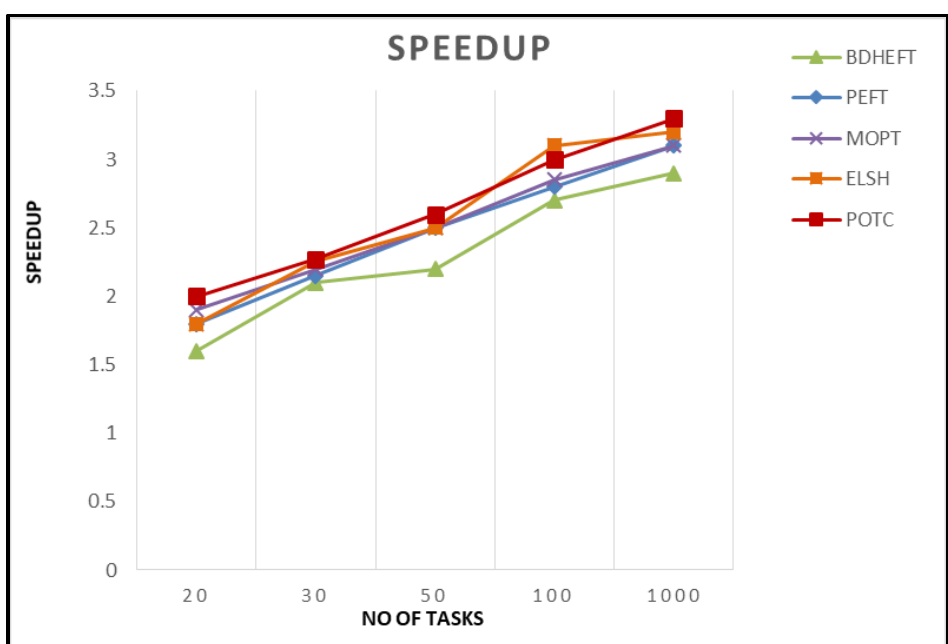
Figure 6. Speedup comparison of the four algorithms.